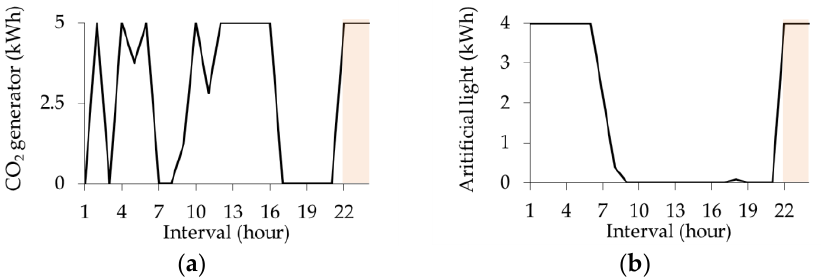
Figure 18. Environmental control of a building microgrid with rooftop greenhouse: ( a ) CO 2 concentration; ( b ) Light intensity.